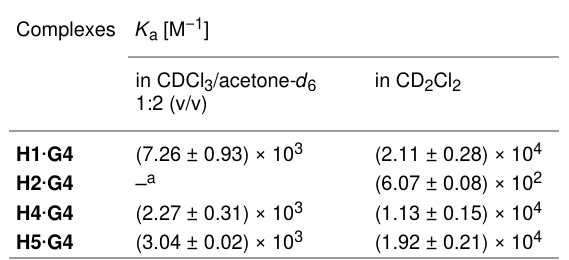
Table 2: Association constants ( K a ) for the 1:1 host–guest complexes in different solvents at 298 K. Complexes K a [M − 1